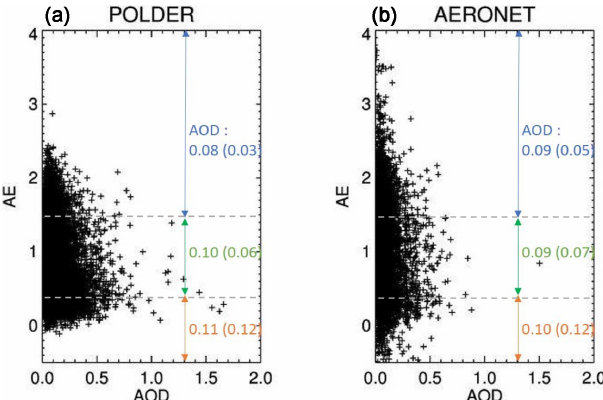
Figure 8. Scatter plot of AE vs. AOD retrieved by POLDER-3 (a) and AERONET (b) on coincidental days ( N = 6421) for the 17 sta- tions of the western Mediterranean Sea. Mean and standard devia- tions (in brackets) of AOD obtained by classifying the air masses into pollution (blue, AE ≥ 1 . 5), mixed (green, 0 . 5 < AE < 1 . 5) and desert dust (orange, AE ≤ 0 . 5) according to Pace et al. (2006) are